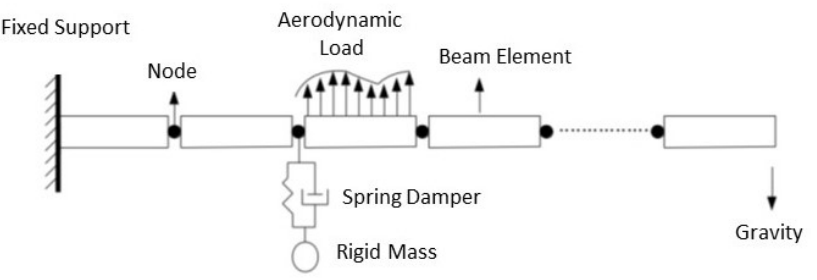
Figure 4. Modeling elements used in aeroelastic wing-store multibody model.